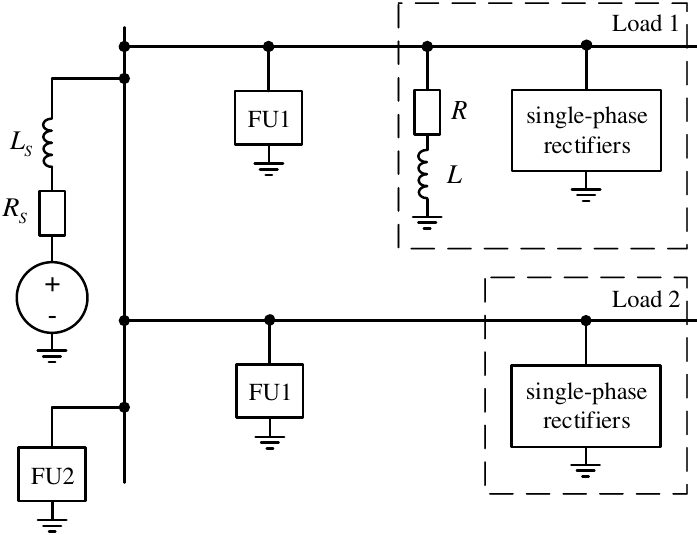
Figure 17. Simplified single-line diagram of the distribution